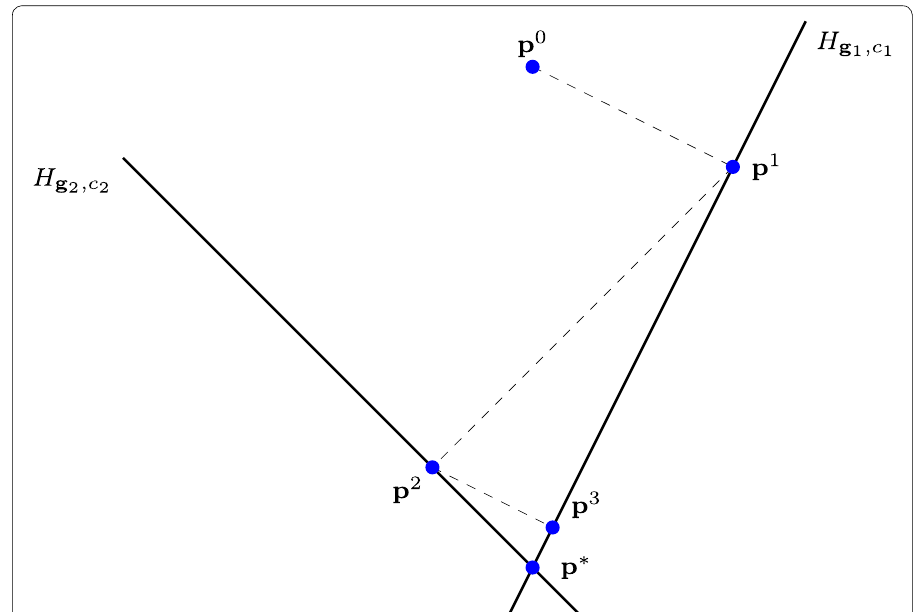
Fig. 2 Visualisation of Kaczmarz’s algorithm. This visualisation shows the concept of Kaczmarz’s algorithm, with two hyperplanes. The initial estimate p 0 is projected onto the first hyperplane, yielding p 1 . The first iterate p 1 is then projected onto the second hyperplane and so forth. Contrary to Cimmino’s algorithm, the iterates produced by Kaczmarz’s algorithm will always adhere to at least one of the constraints given by the rows of the matrix G . Although the convergence appears to be a lot faster for this simple example, it can be extremely slow for larger problems in higher dimensions. The algorithm will therefore only be used for a certain class of subproblems that occur during the projection step of Cimmino’s